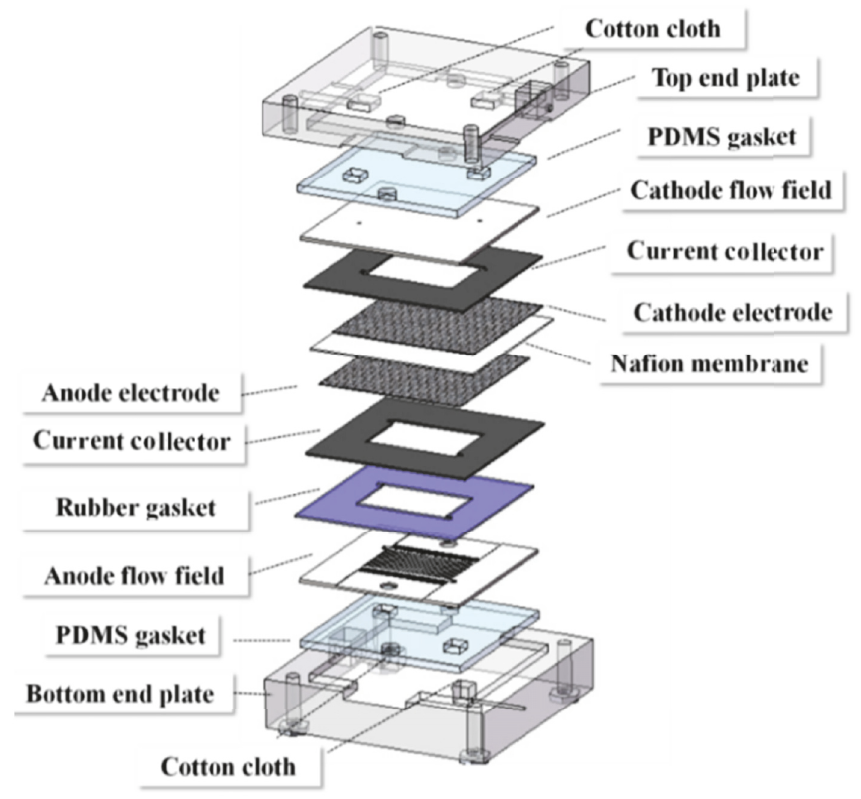
Figure 4: Single self-pumping EBC assembly as a sandwich structure and related components.